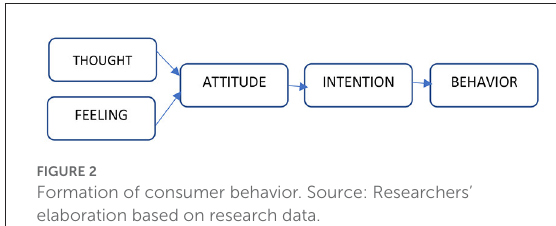
FIGURE2 Formation of consumer behavior. Source: Researchers’ elaboration based on research